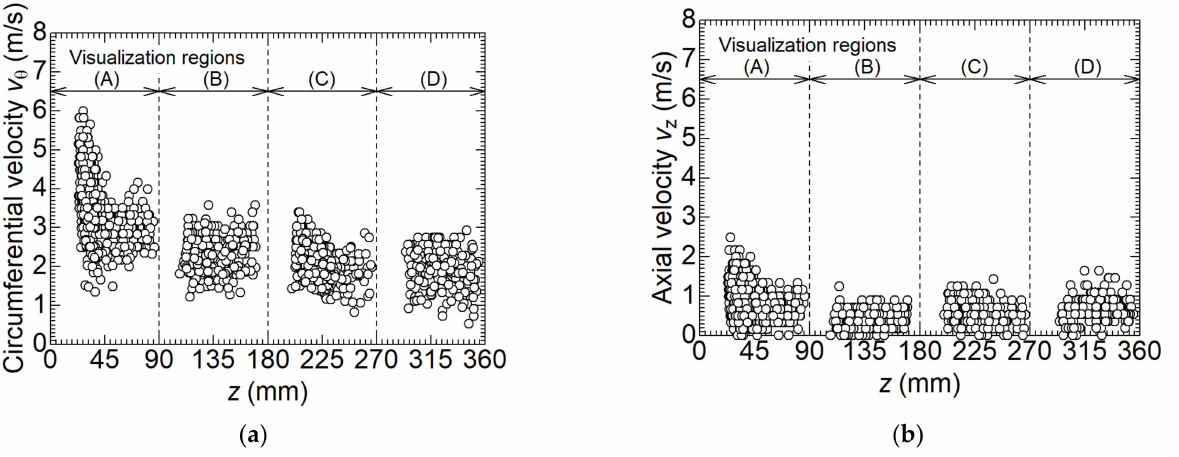
Figure 11. Variations in particle velocities along the z -axis: ( a ) circumferential velocity v θ ; ( b ) axial velocity v z